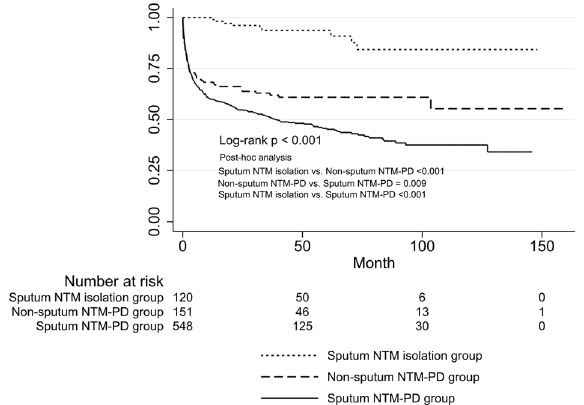
Figure 3. Comparison of time to initiation of treatment for nontuberculous mycobacterial pulmonary disease (NTM-PD). Treatment-free survival was significantly different between the groups (Log rank P < 0.001). Post- hoc analysis on the log-rank test with Bonferroni’s correction showed that treatment-free survival significantly increased in the order of the sputum NTM isolation, the non-sputum NTM-PD, and the sputum NTM isolation group. Patients with a single NTM isolation from sputum were designated as the sputum NTM isolation group, patients with positive results from bronchoscopic [e.g., bronchial washing or bronchoalveolar lavage (BAL)] or lung tissue specimens were designated as the NTM-PD group diagnosed using other methods (non-sputum NTM-PD group), and patients with NTM isolation at least two times from separately expectorated sputum samples were designated as the NTM-PD group diagnosed using sputum culture (sputum NTM-PD group).